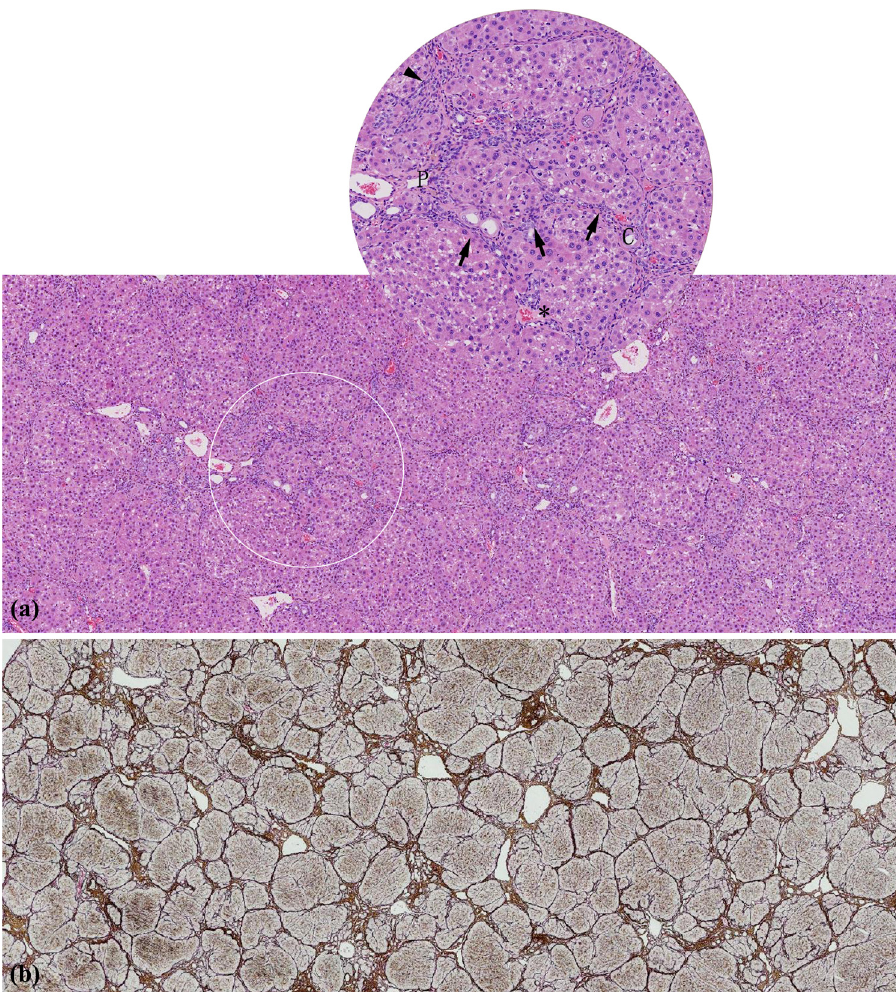
Figure 6: Pathological changes in the liver after administration for 8 weeks in CCl 4 group. ( a ) Disordered lobules with extensive degen - eration of hepatocytes, patchy coagulation necrosis ( * ) , interlobular fusion necrosis ( triangle ) , and portal area - central vein bridging necrosis ( arrow ) , accompanied by a large amount of in fl ammatory cell in fi ltration ( HE 40 × and HE 100 ×) . ( b ) Di ff use proliferation of fi brous tissues between hepatic lobules ( Reticulum Masson 20 ×) . C: central veins, P: portal